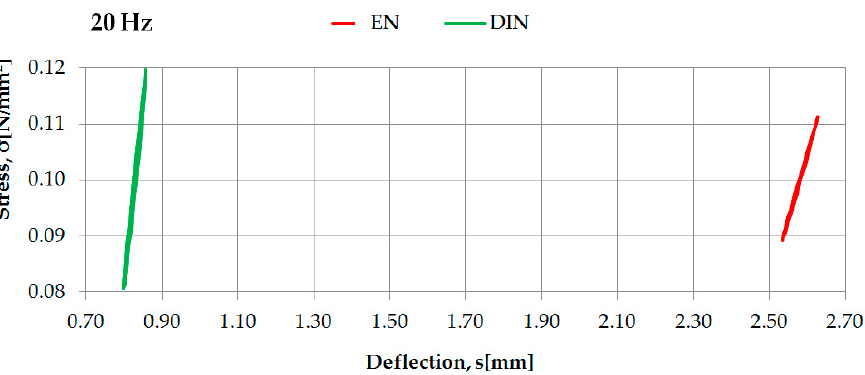
Figure 7. Dynamic characteristics in high frequencies of UBM 042 determined according to DIN [23] and EN [24].